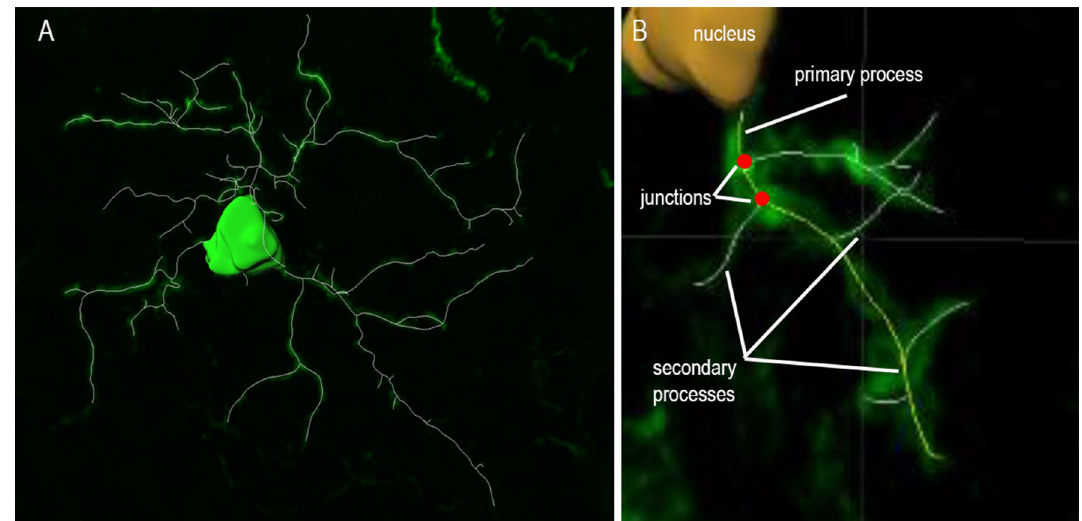
Figure 4. Example of microglial cell after 3D-reconstruction in Imaris with illustration of ( A ) primary processes, ( B ) junctions and ( C ) secondary